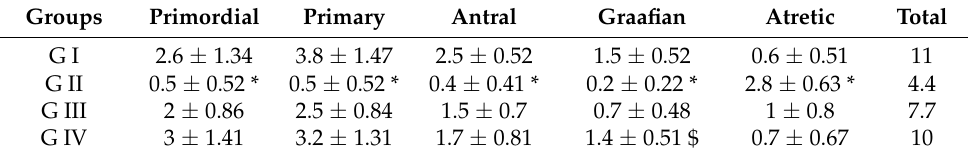
Table 4. Mean number of ovarian follicles (per section) in different stages of development.